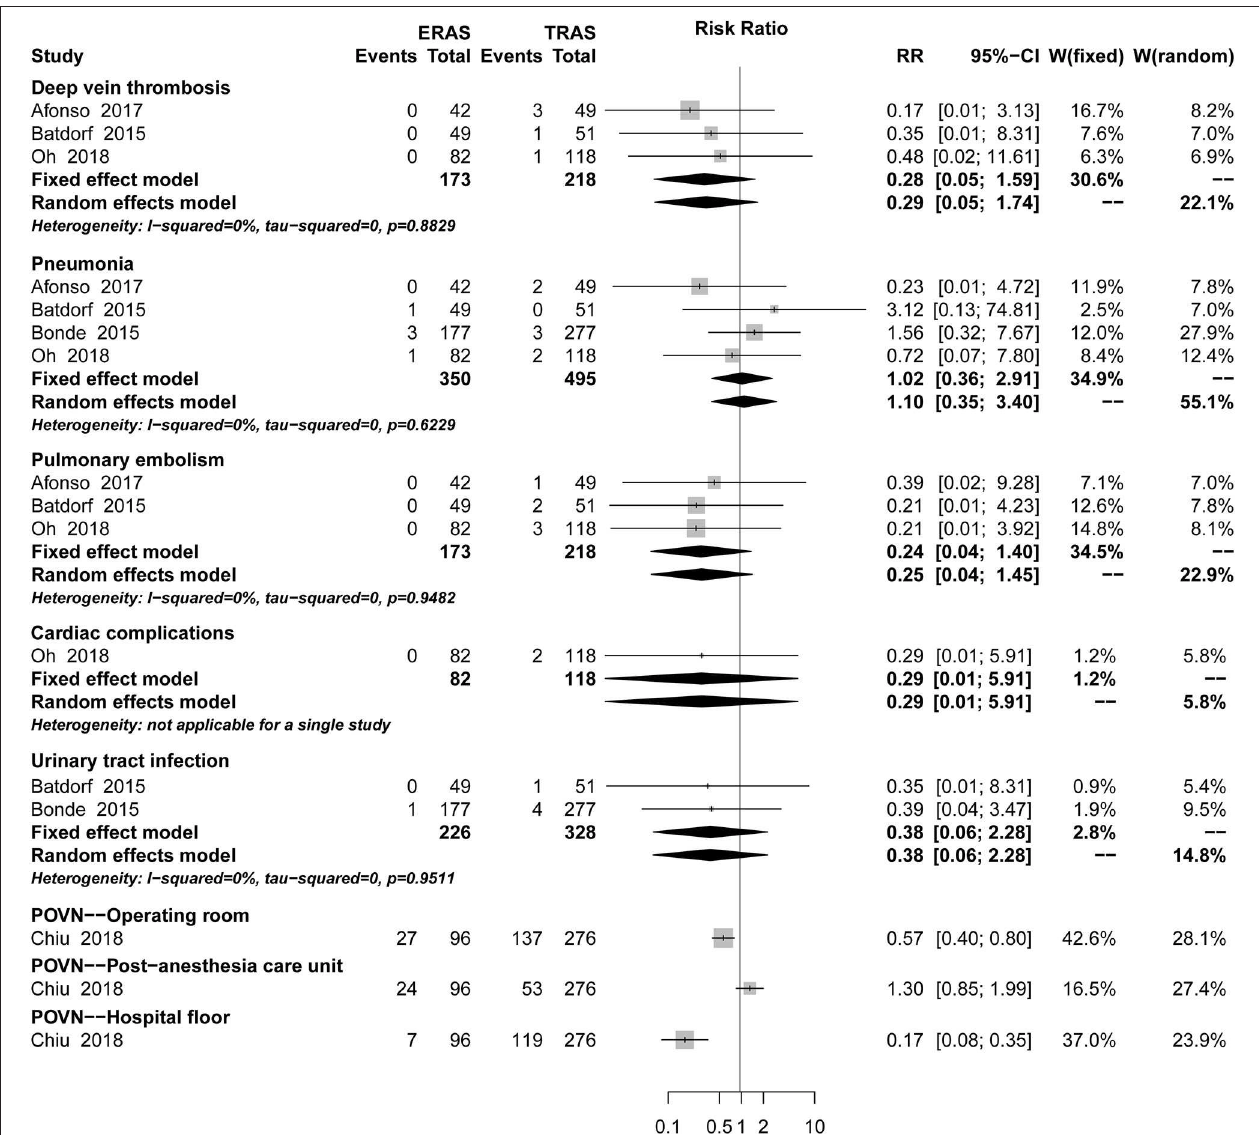
FIGURE 4 | Pooled estimate of the effect of ERAS programs on incidence of systemic complications within 30 days after autologous breast reconstruction surgery compared to conventional perioperative care